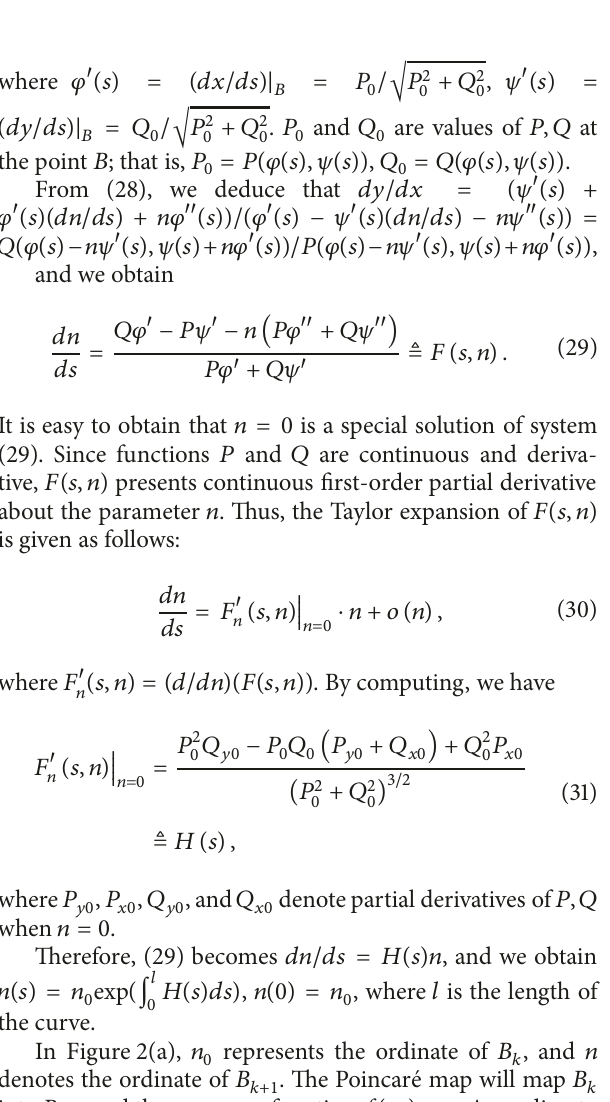
Figure 2: The stability of the order-1 periodic solution of system (3) for 𝑥 2 < 𝑥 ∗ 2 . (b) Γ 𝑛 is the order-1 periodic solution of system (32).